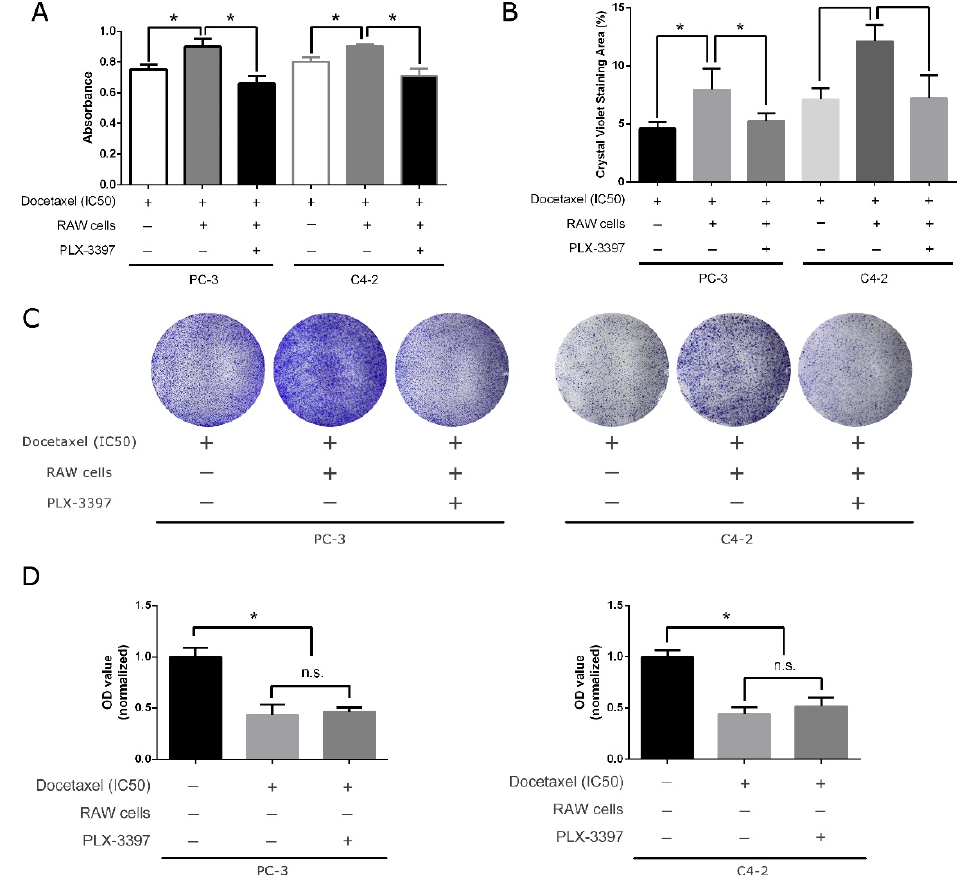
Figure 2. CSF-1R inhibitor pexidartinib can negate the pro-survival effect caused by tumor-associated macrophages. ( A ) Pexidartinib can restore sensitivity to docetaxel in PC-3 and C4-2 cells in MTS assay. ( B ) In the colony formation assay, pexidartinib was also shown to have an effect on removing protection from RAW cells in PC-3 cells and C4-2 cells. ( C ) Representative images of colony formation assay stained by crystal violet. ( D ) Without RAW cells, pexidartinib alone does not change docetaxel sensitivity in PC-3 and C4-2 cells. All treatment durations were 48 h before cell seeding in the colony formation assay, and experiments were repeated three times. *: p < 0.05; n.s.: not